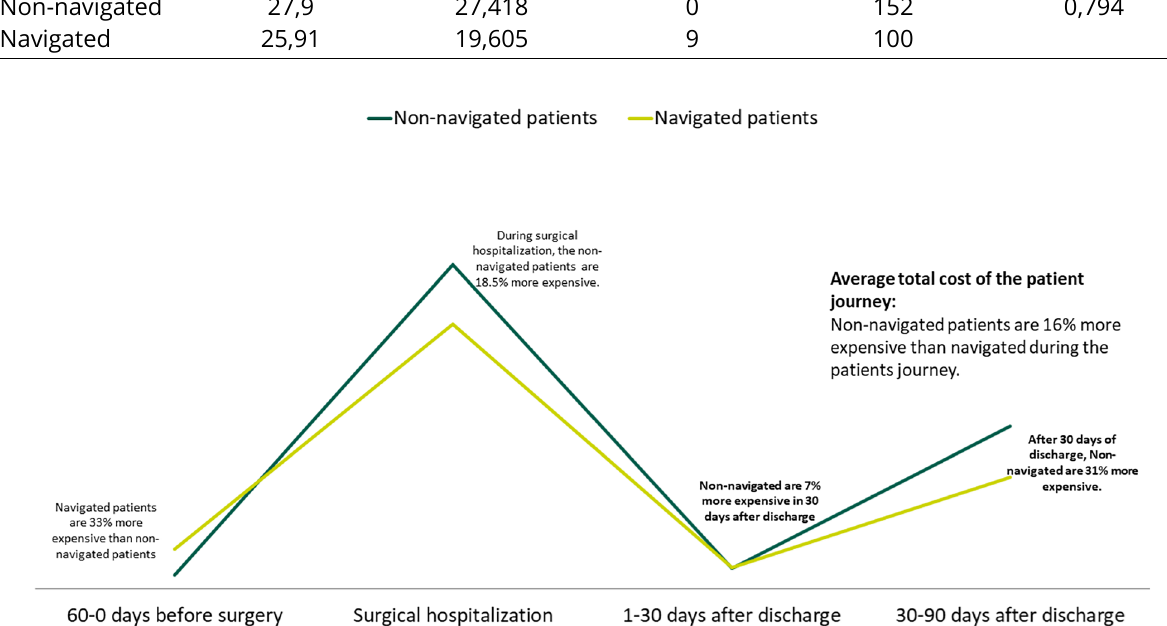
Graph 1. Mean revenue per patient during the patients'